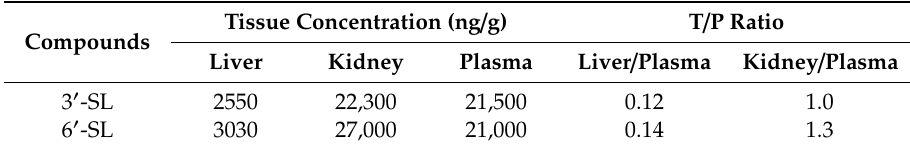
Table 6. Tissue to plasma (T / P) concentration ratios of 3 (cid:48) -SL and 6 (cid:48) -SL at 2 h after intravenous administration of a dose of 12.5 mg /